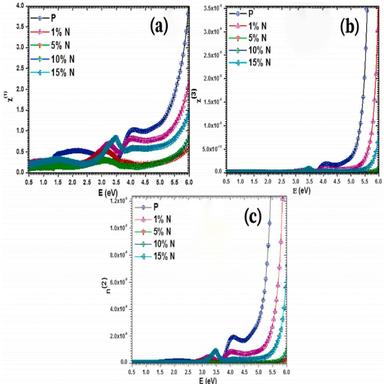
Plots of variation of (a) χ1 , (b) χ3 and (c) n2 of 1%, 5%, 10%, 15% N doped NiO thin films respectively.